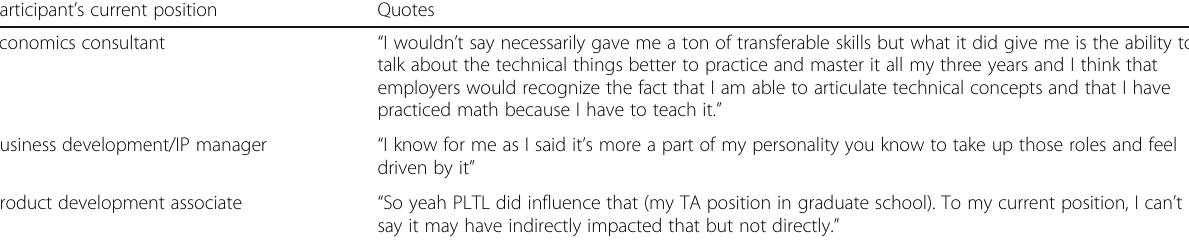
Table 5 Key quotes from participants which indicate that transferable skills were not solely caused by PLTL Participant ’ s current position Quotes Economics